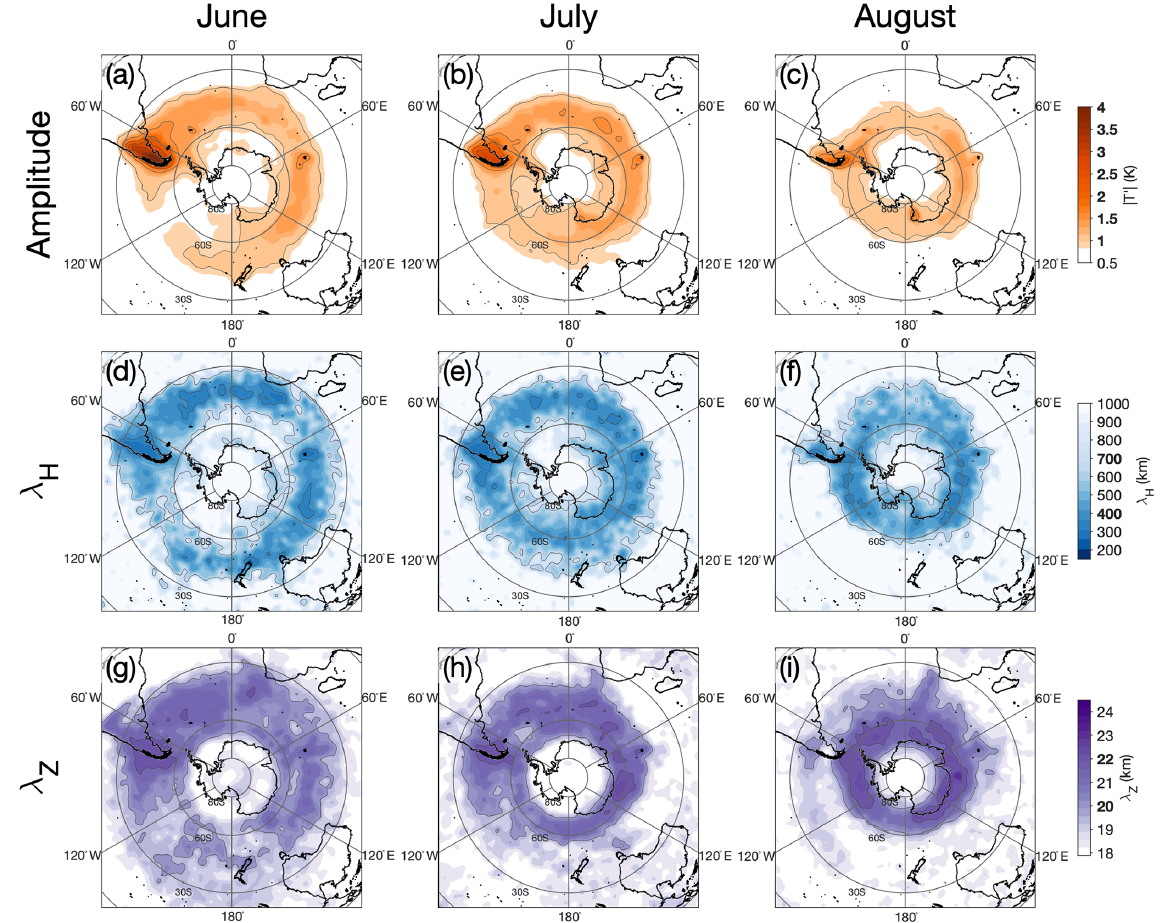
Figure 7. Monthly mean gravity wave amplitude (a, b, c) , horizontal wavelength (d, e, f) and vertical wavelength (g, h, i) at z = 40km over the Southern Ocean during June, July and August 2010 from 3-D AIRS measurements. To guide the eye, thin grey contours are drawn at the values marked in bold on the colour